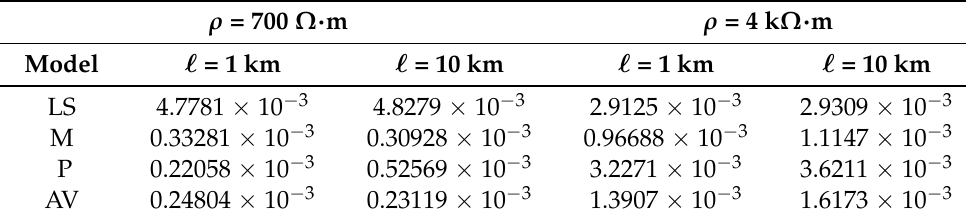
Table 7. χ ( % ) for the frequency-domain voltage V 0 in mode 0 for the considered FD soil models. ρ = 700 Ω · m Model